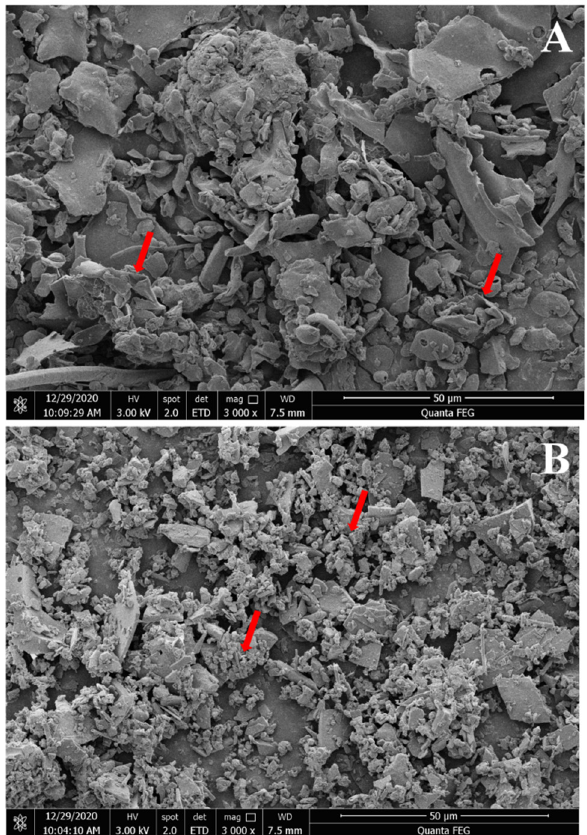
Figure 3. Scanning electron micrographs of two Rehmannia glutinosa polysaccharides. Magnifications of 3000 × for RGP − 1 − A ( A ) and RGP − 2 − A ( B ). RGP − 1 − A: Rehmannia glutinosa polysaccharides decolorized by the AB-8 macroporous resin; RGP − 2 − A: Rehmannia glutinosa polysaccharides decol- orized by H 2 O 2 . The red arrows indicate significant